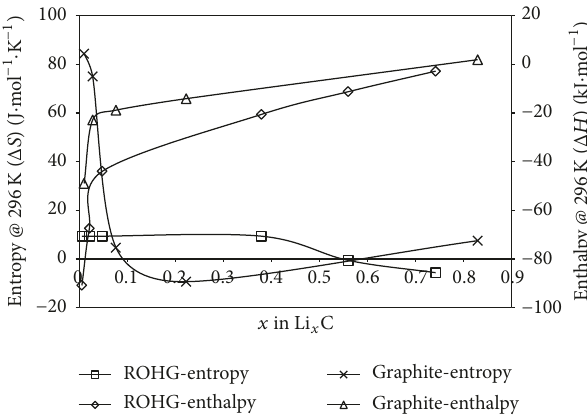
Figure 6: Entropy and enthalpy change with moles of lithium intercalated in